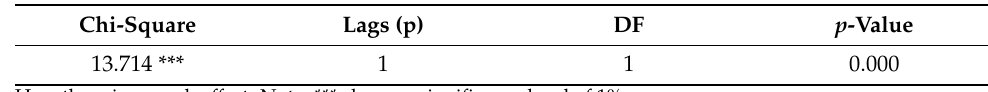
Figure 3. Scatter plots of the currencies. Table 4. Arch